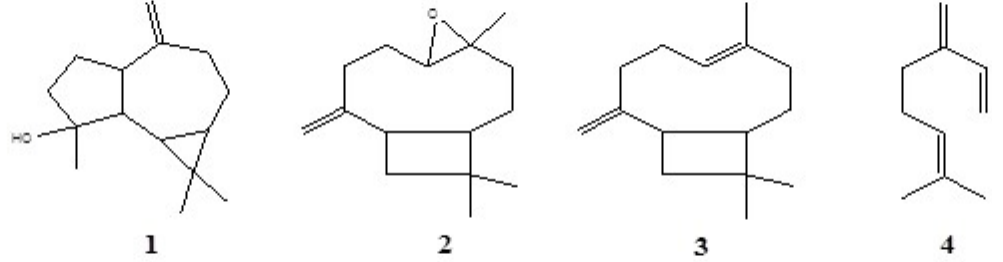
Figure 1 - Chemical structures of the four major constituents identified in the essential oil from P. ovatum leaves: (1) spathulenol, (2) caryophyllene oxide, (3) β-caryophyllene and (4) myrcene.